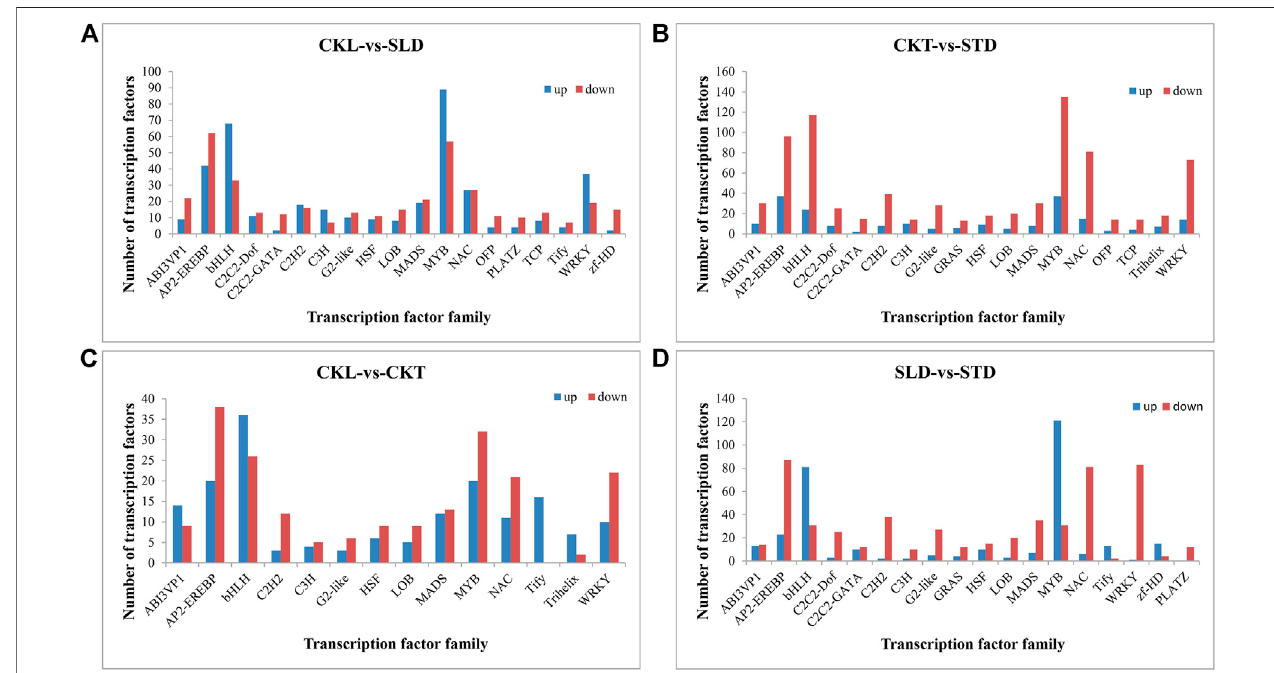
FIGURE5| Comparisonofmajordifferentiallyexpressedtranscriptionfactorfamiliesin B.rapa underfreezingtreatments.Thedifferentiallyexpressedtranscription factors in CKL vs. SLD (A) , CKT vs . STD (B) , CKL vs . CKT (C) , and SLD vs . STD (D) .